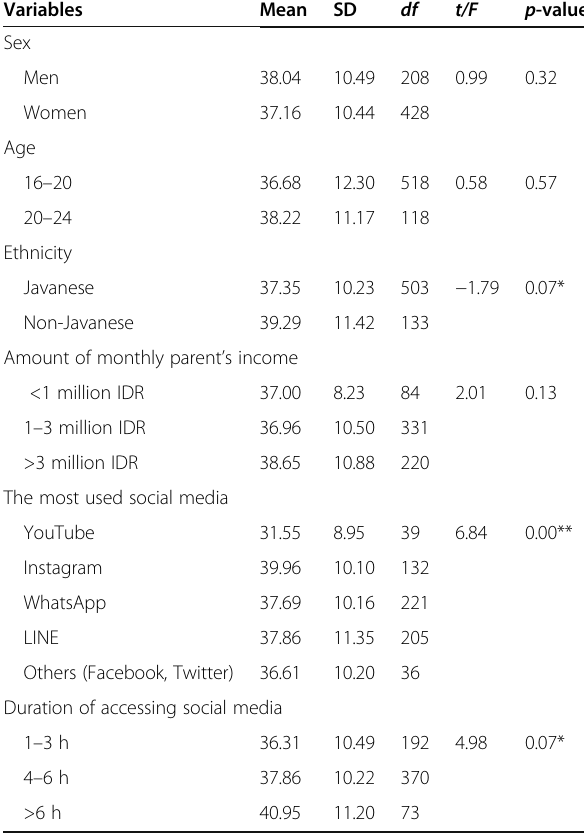
Table 2 Demographic data associated with FoMO